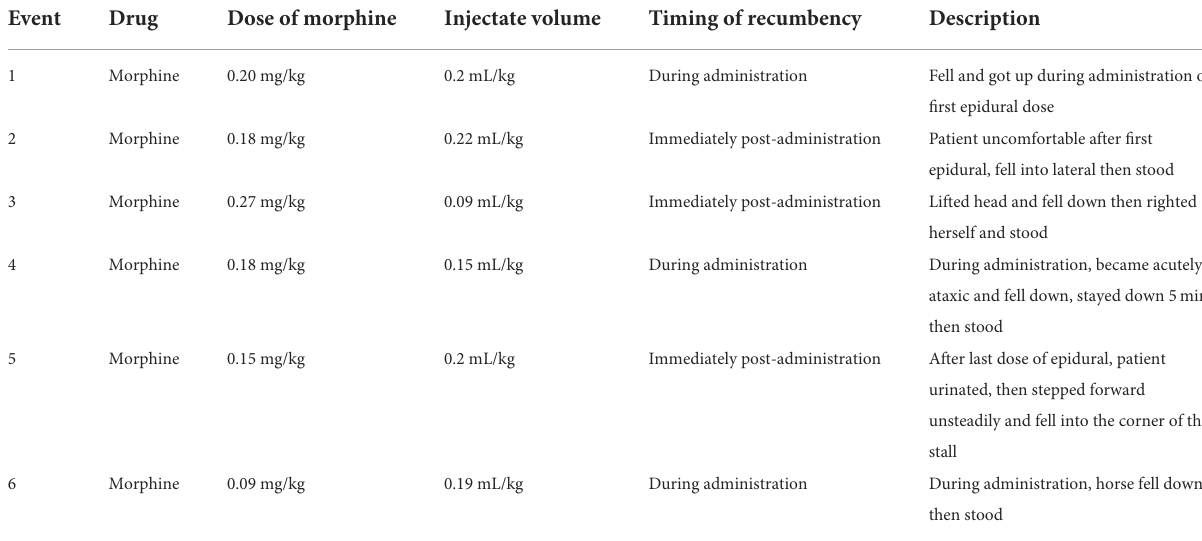
TABLE 3 Occurrences of recumbency during or following epidural administration.